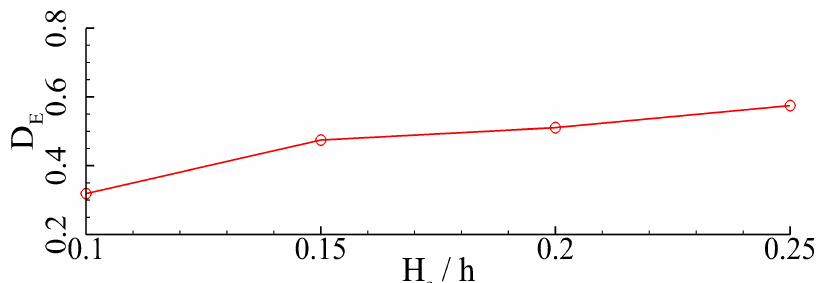
Figure 15. Dissipation rate of the wave energy under different significant wave heights.